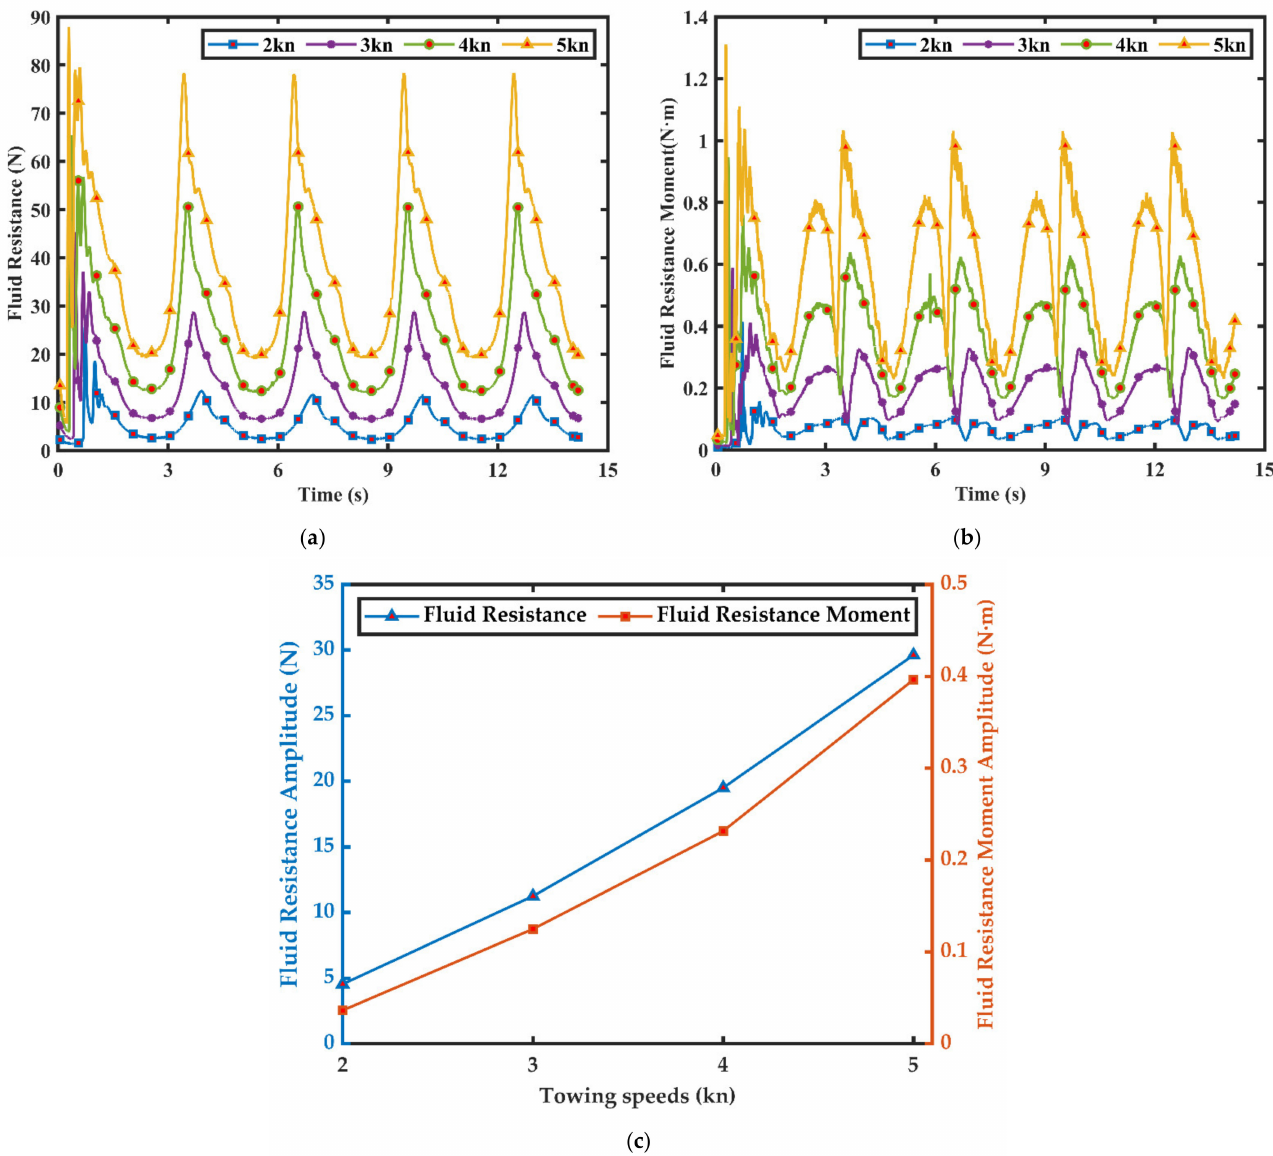
Figure 10. The time history of the fluid resistance and moment of the tethered underwater robot at different towing speeds: ( a ) the fluid resistance of the tethered underwater robot; ( b ) the fluid resistance moment of the tethered underwater robot; ( c ) the average amplitude of fluid resistance amplitude and fluid resistance